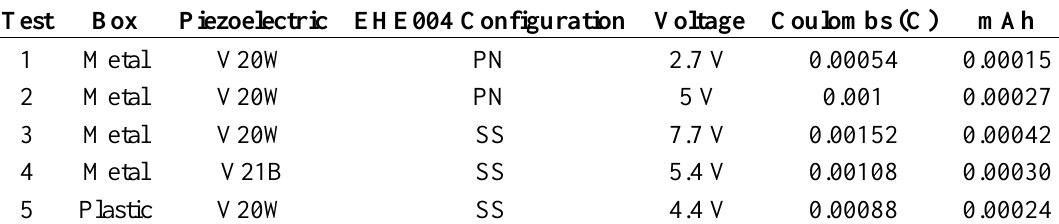
Table 9. Piezoelectric